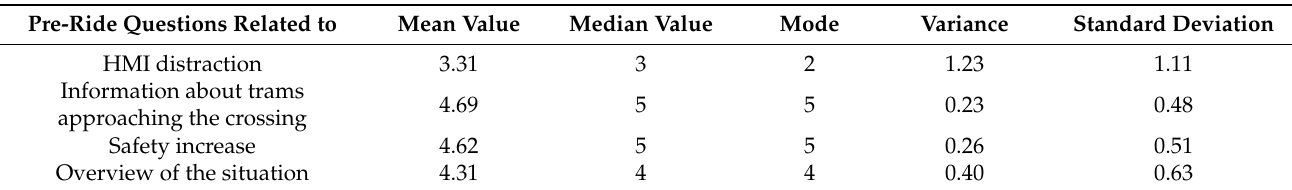
Table 1. The results from pre-ride questionnaires including specific questions on general and the use-case Public Transport Vehicle